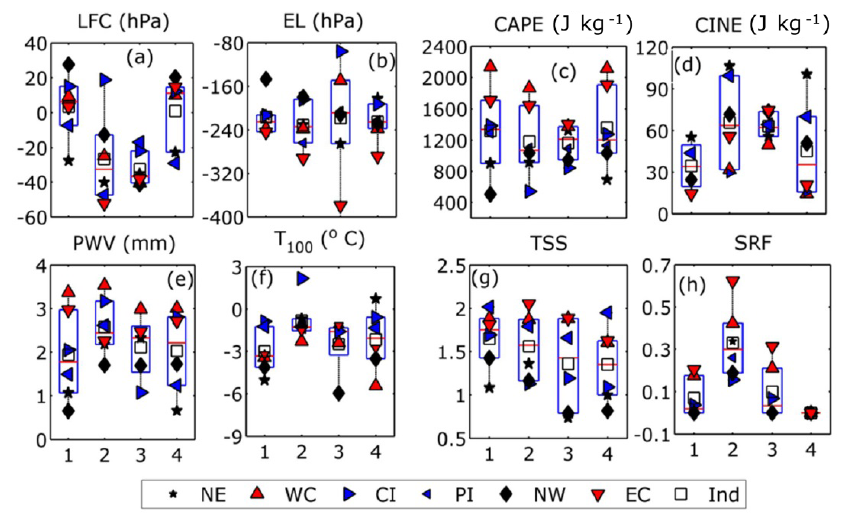
Figure 6. Seasonal trend of long-term variation for (a) LFC, (b) EL, (c) CAPE, (d) CINE, (e) PWV, (f) T 100, (g) TSS, and (h) SRF over India during all seasons. Seasons are denoted as follows: (1) pre-monsoon (March–May), (2) monsoon (June–September), (3) post-monsoon (October–November), and (4) winter (December–February). Legends are the same as in Fig.